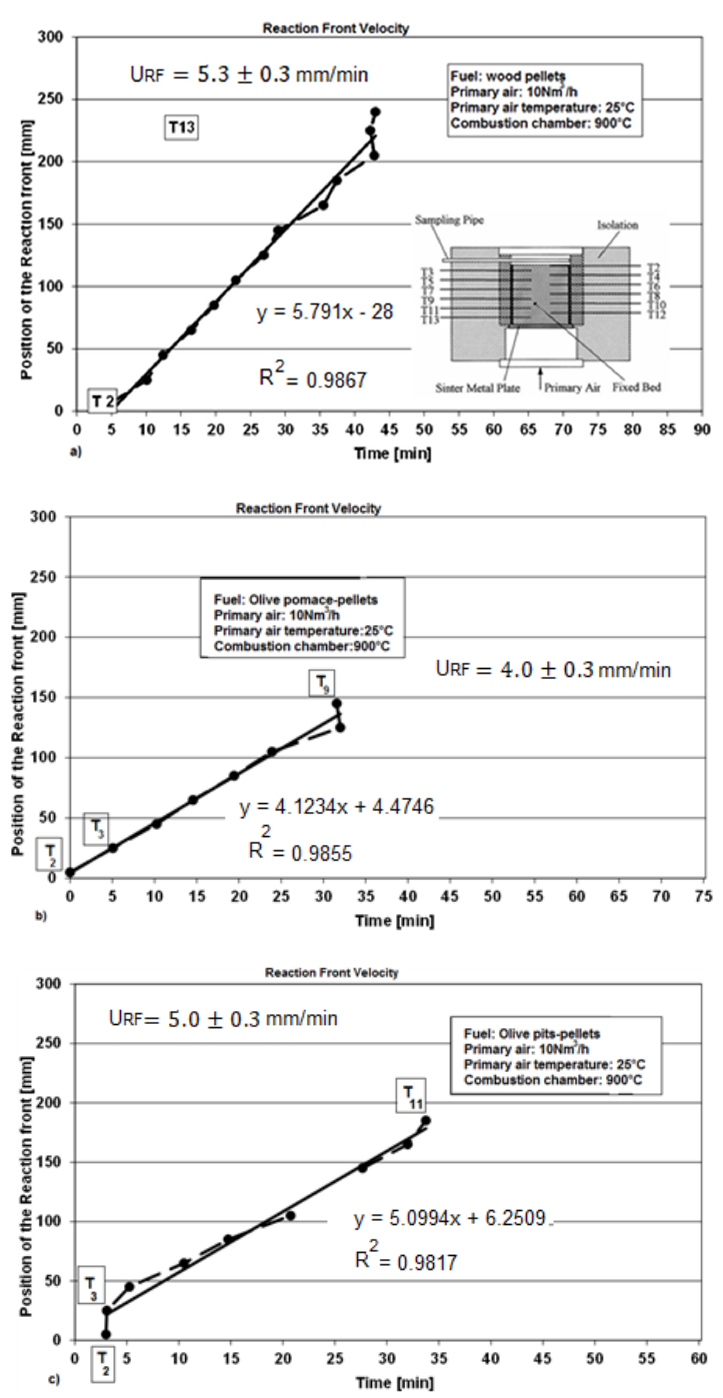
Figure 4. Reaction front positions derived from experimental pellets tests: ( a ) standard wood pellets; ( b ) 100% olive pomace (OP); ( c ) 100% olive pits (OP i ). Experimental conditions: Primary air 10 Nm 3 /h; primary air temperature 25 °C and combustion chamber temperature 900 °C.